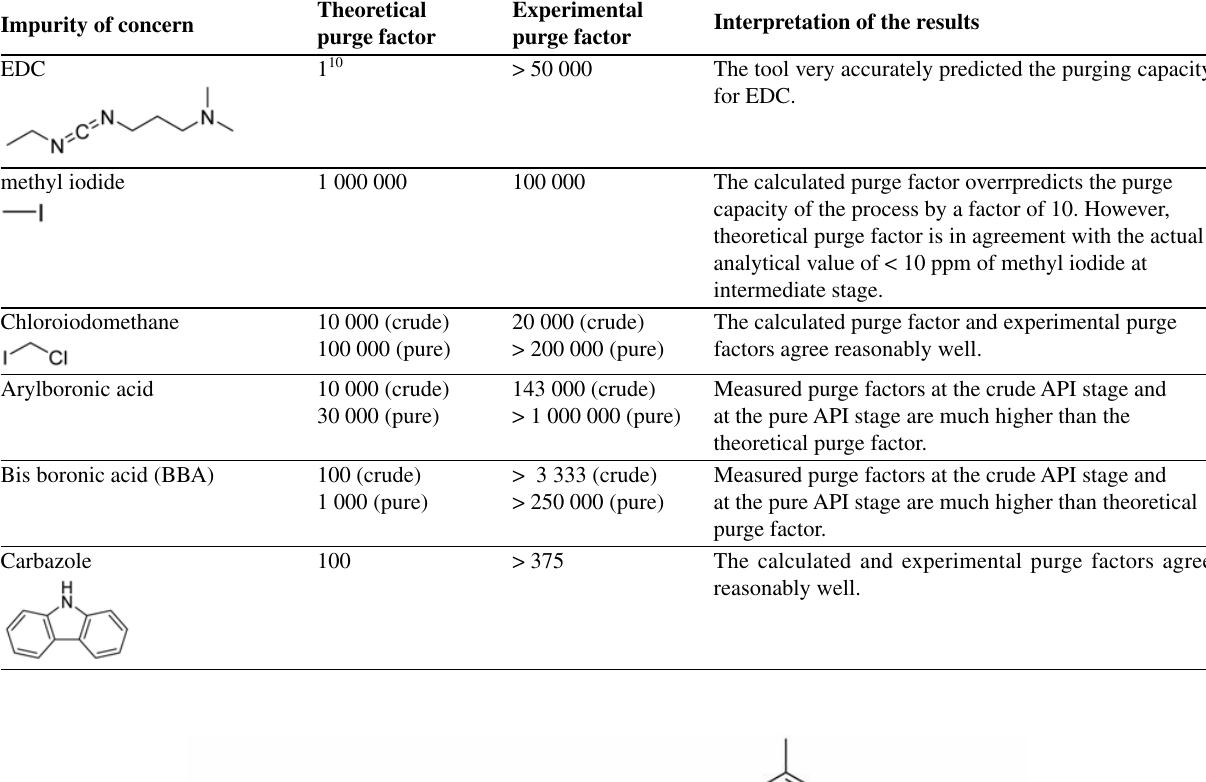
Table 6. Summarized results of the case study for the synthesis of MK-8876 (based on McLaughlin et al. 33